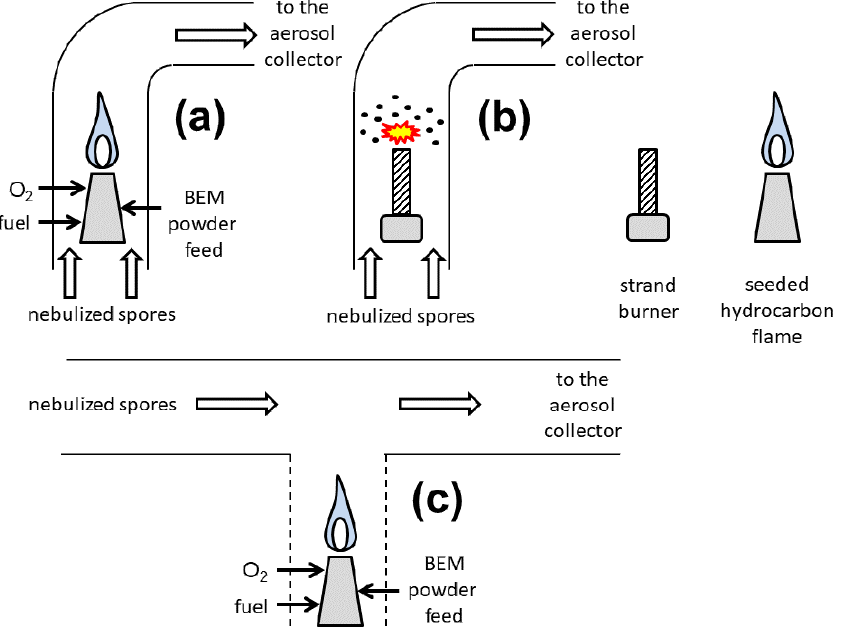
Figure 4. Schemes of the exposure chamber, adapted and modified from Refs. [173,177], according to three different technical solutions: ( a ) axial exposure chamber with a gas burner for BEM combustion; ( b ) axial exposure chamber with a solid strand burner; ( c ) tangential gas burner with adjustable distance (dashed lines) between the flame and the aerosolized stream.